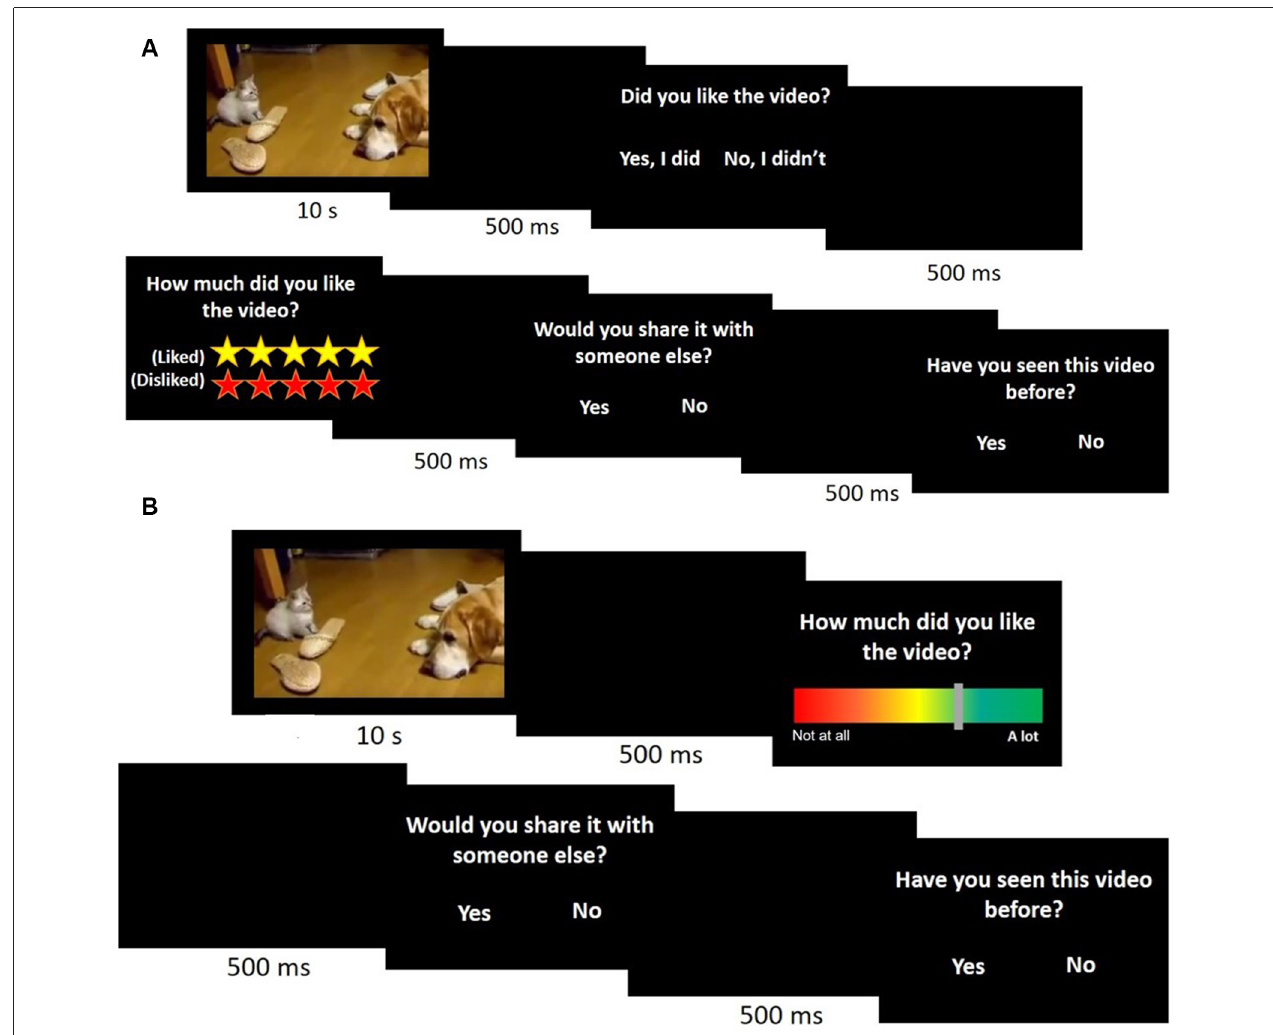
FIGURE 1 | Main experimental design. A cohort of 23 participants watched 100 10-s videos and answered four ( A , n = 11) or three ( B , n = 12) questions immediately after viewing each one.